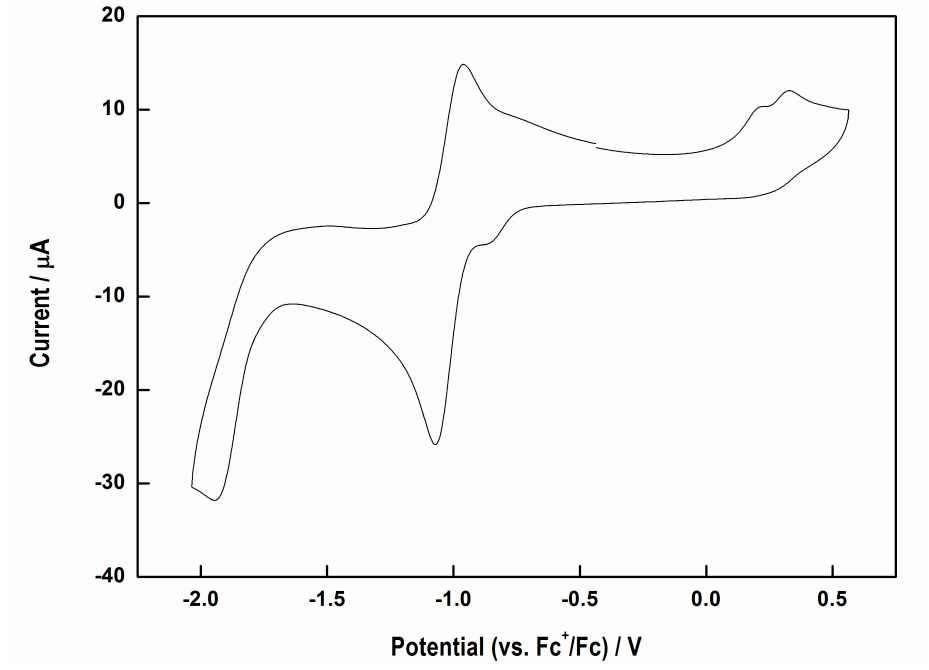
Figure A8. Cyclic voltammetry of ( 1-L4 ) showing the second reduction and accompanying anodic